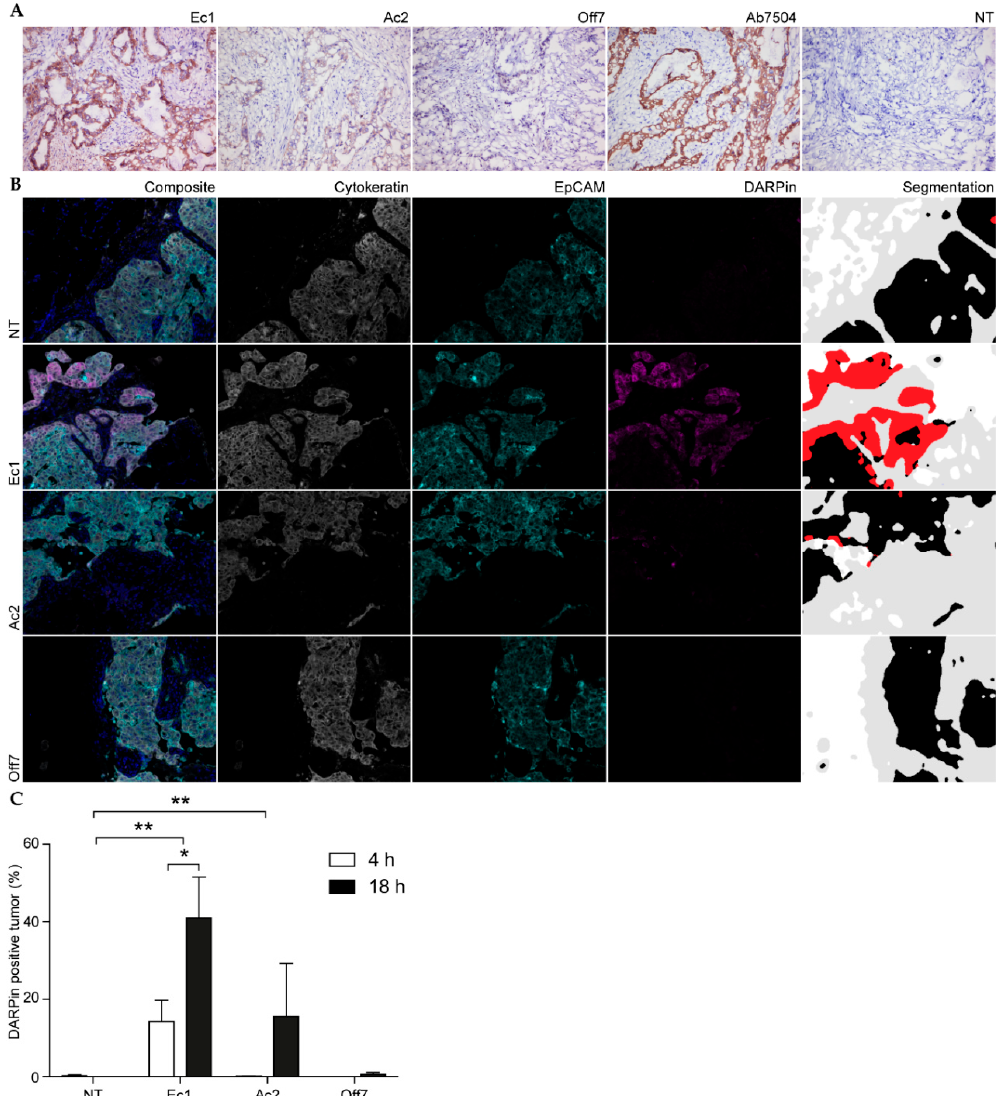
Figure 6. Binding of DARPins to primary tumor tissue. ( A ) Cryosections of ovarian cancer tissue incubated with DARPins and visualized with DAB immunohistochemistry. ( B ) Representative images of metastatic ovarian tumor tissue that was incubated alive ex vivo before fixation. Slices were incubated for 4 h with DARPins. They were subsequently processed and stained via multiplex immunohistochemistry. A composite image is shown with blue-stained nuclei. This is followed by the separate image of each staining. Lastly, a segmentation image is added that gives a clear overview of the presence of stroma (gray), tumor (black) and DARPin (red). The DARPin-positive areas in these experiments were also EpCAM positive, but are only shown in red. ( C ) The percentage of positive tumor area after 4 and 18 h was calculated by dividing the DARPin-positive tumor surface area by the total tumor surface area (sum of DARPin-positive and negative tumor surface areas). Mean and s.e.m. are shown. Significance was determined with a two-way ANOVA and Bonferroni post hoc test. * p < 0.05, ** p < 0.01. n = 3.